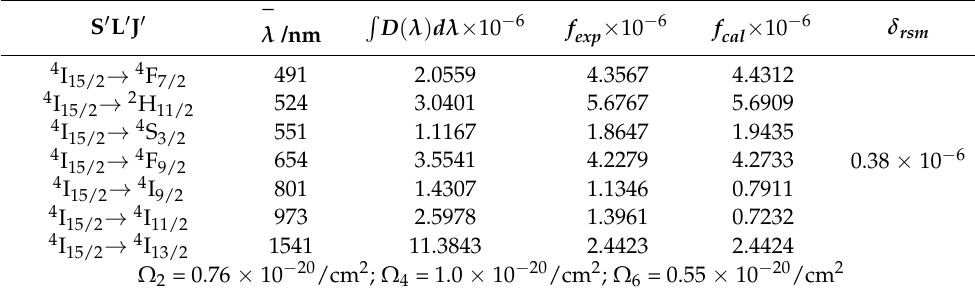
Table 2. fcal, fexp, δ rsm and Ω t ( t = 2, 4 and 6) of Er 3+ in the PMN-32PT:Er 3+ /Sc 3+